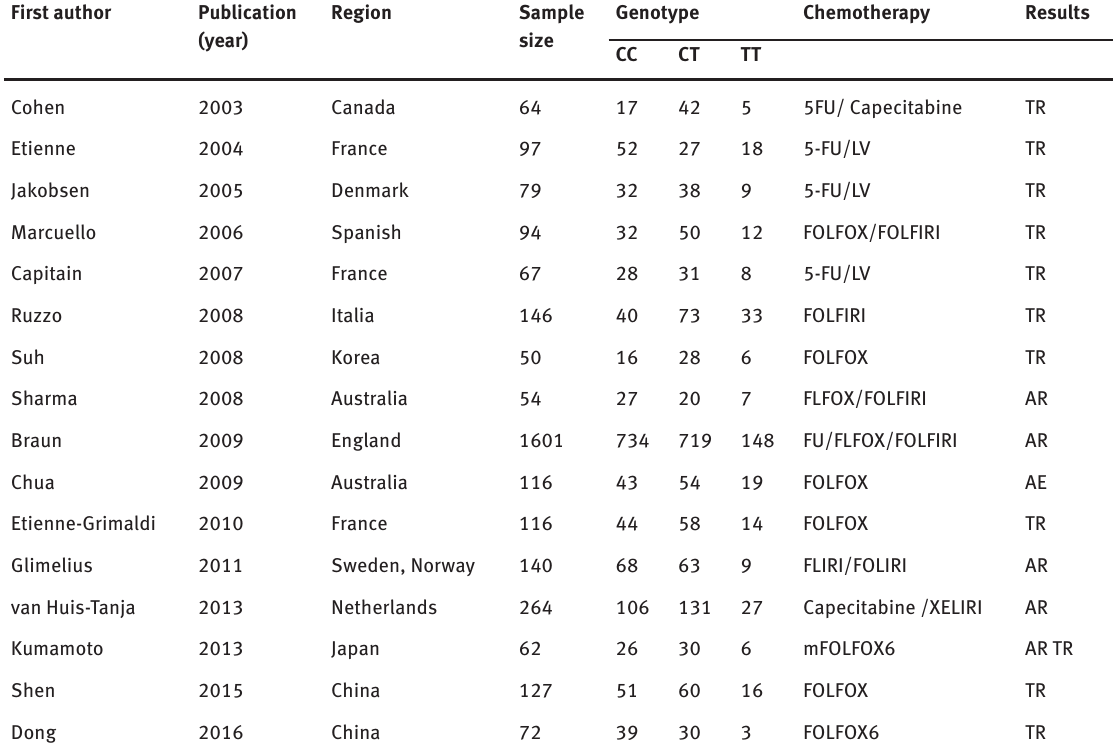
Table 1: General characteristics of the included 16 studies.